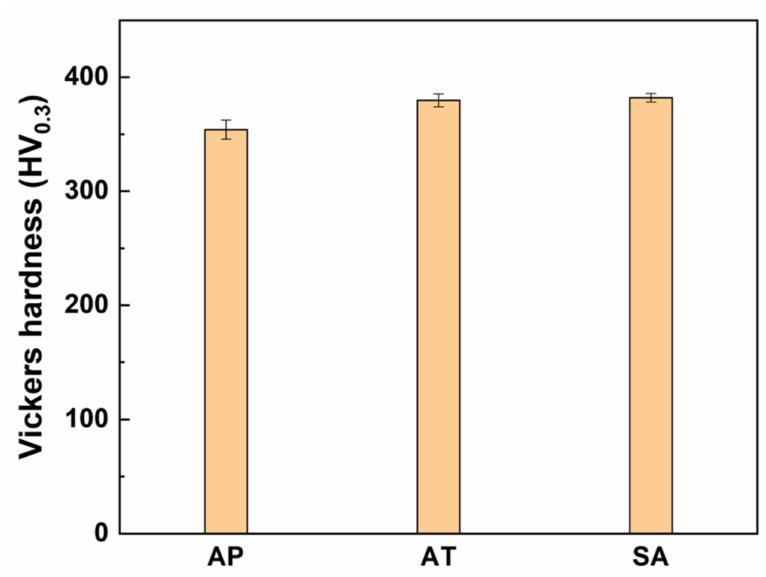
Figure 6. Vickers hardness measurements for AP, AT and SA